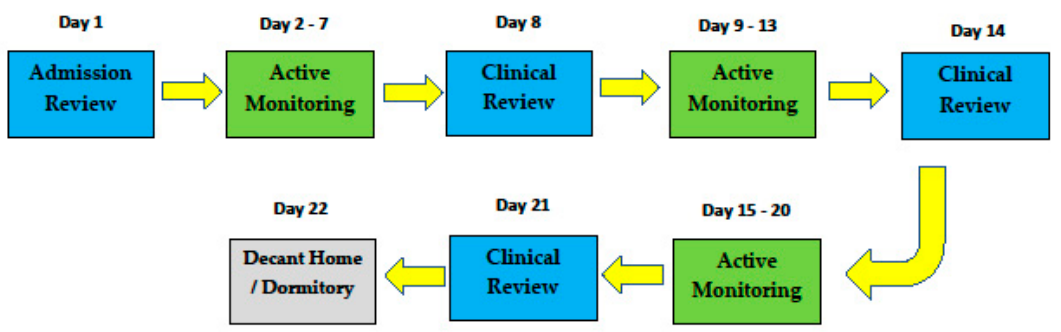
Figure 3. Patient’s journey in the CCF.